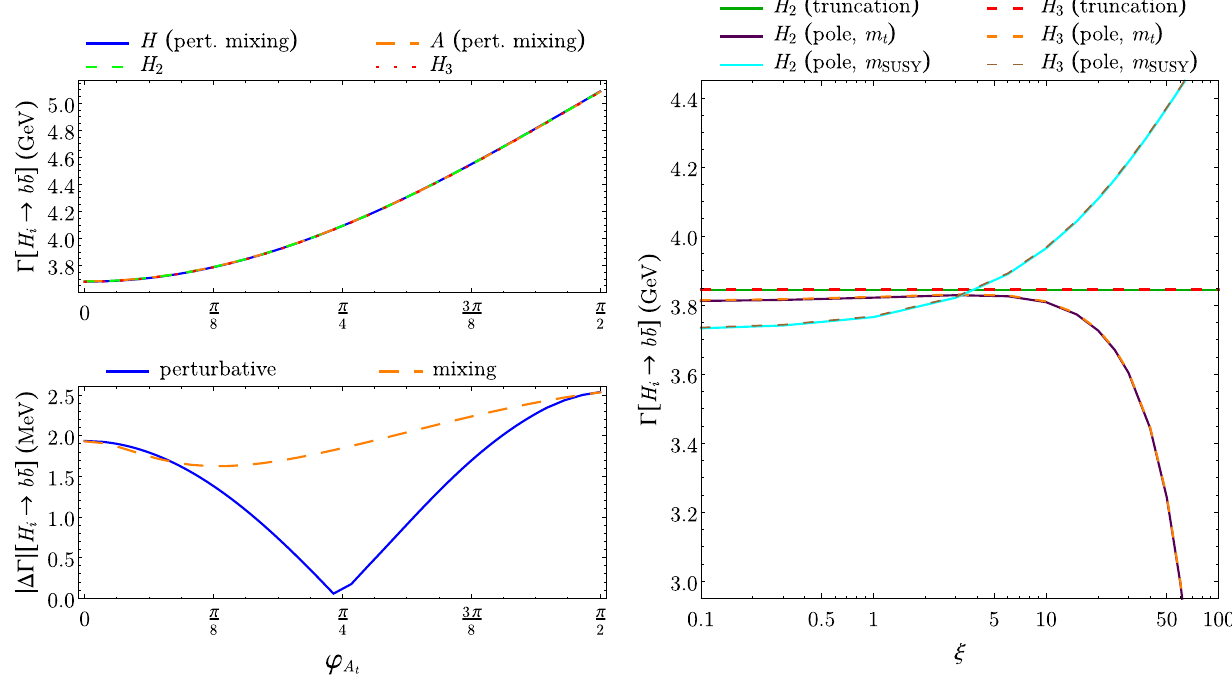
The gauge- and field-renormalization dependence of the decay widths obtained with Eq.(13) (green and dashed red) and with the mixing for- malism associated to an iterative pole search (purple and dashed orange for field counterterms at the scale m t ; blue and dashed brown for field counterterms at the scale m SUSY ) are shown. Due to the SU ( 2 ) L sym- metry, the curves appear in overlapping